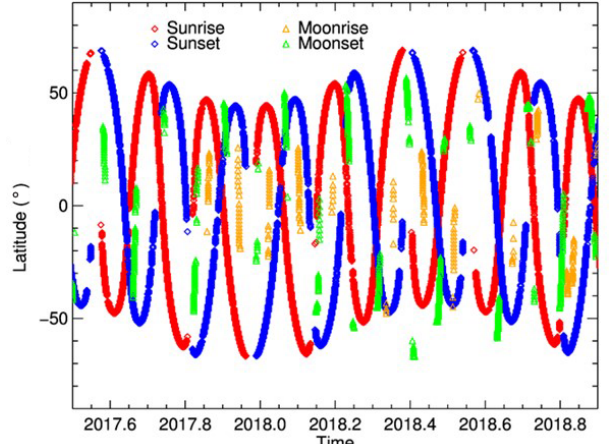
Figure 1. The SAGE III-ISS solar and lunar occultation coverage from June 2017 to November 2018. The red curves show the sunrise events, the blue curves show the sunset events, the orange curves show the moon rise events, and the green curves show the moonset events. The horizontal axis indicates year and fraction of a